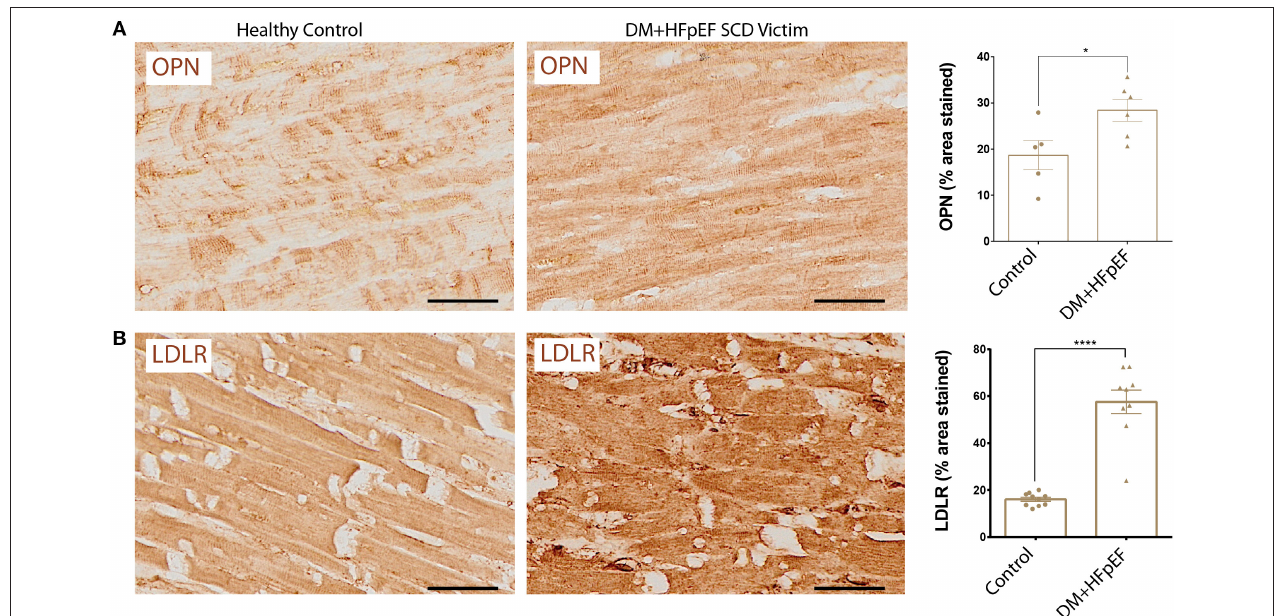
FIGURE 1 | Upregulation of OPN and LDLR in SCD victims with DM + HFpEF. Immunostaining of cardiac biopsies of SCD victims with both HFpEF and DM shows upregulated OPN (A) and LDLR (B) protein expression compared to control hearts. Data are mean ± SEM. N = 5–10 subjects/group. Scale bar = 50 µ m. HFpEF, Heart Failure with Preserved Ejection Fraction; DM, Diabetes Mellitus; LDLR, Low Density Lipoprotein Receptor; OPN, Osteopontin. * P < 0.05, **** P < 0.0001 using Student’s t -test.